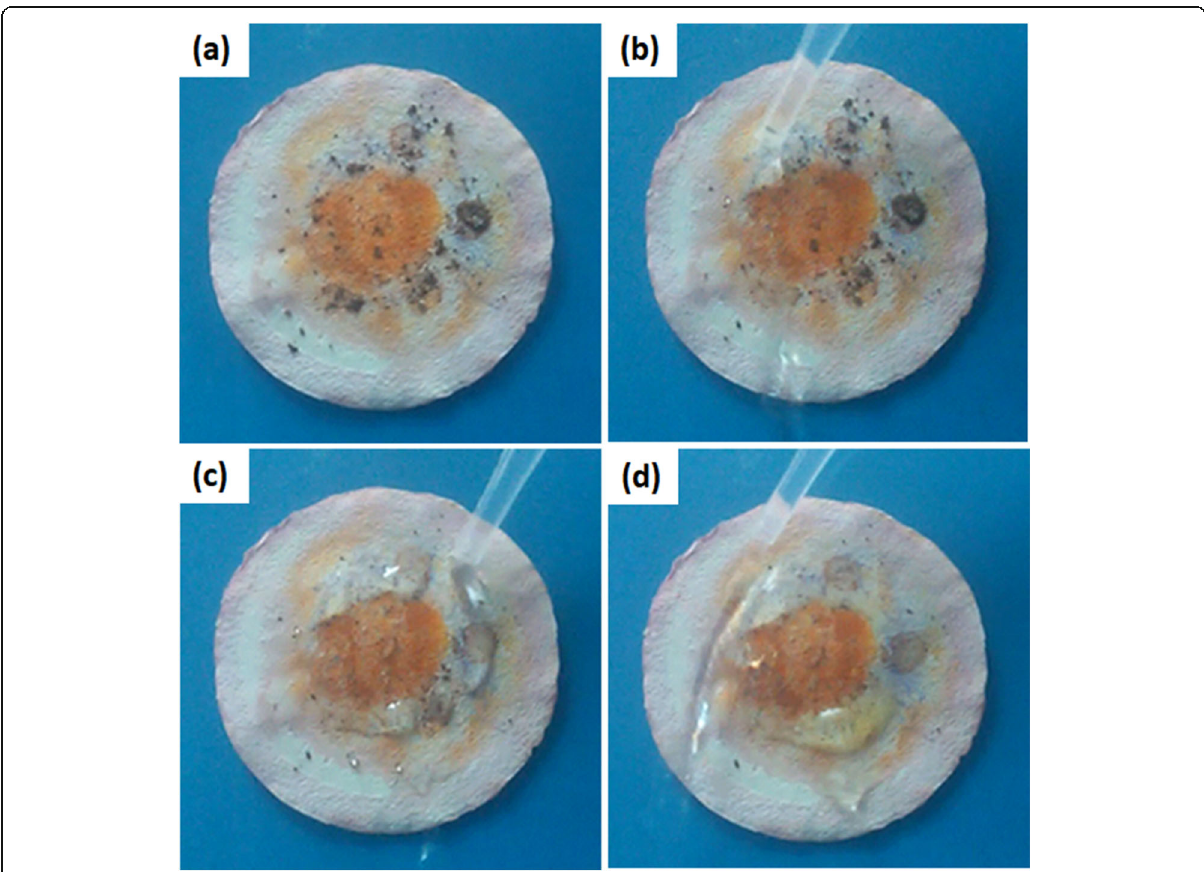
Fig. 7 Digital images of self-cleaning